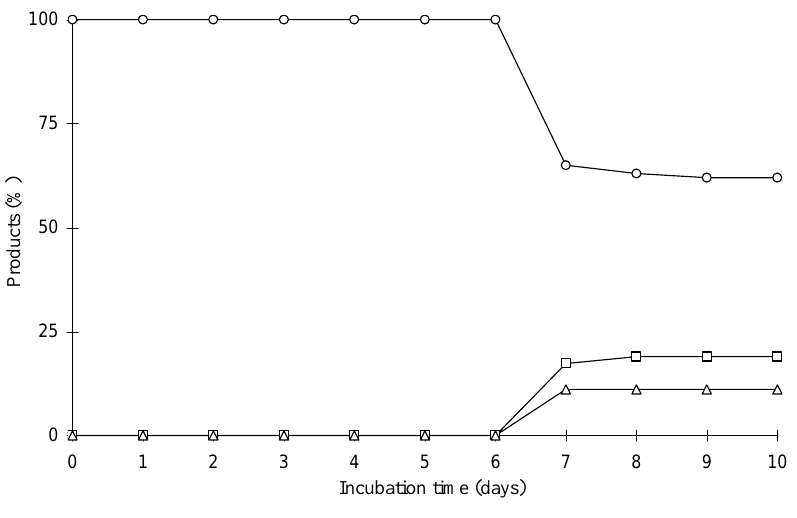
Figure 5. Time course in the biotransformation of lupeol by A. ochraceus : ( (cid:123) ) lupeol; ( (cid:133) ) compound 2 ; ( (cid:85) ) compound 3